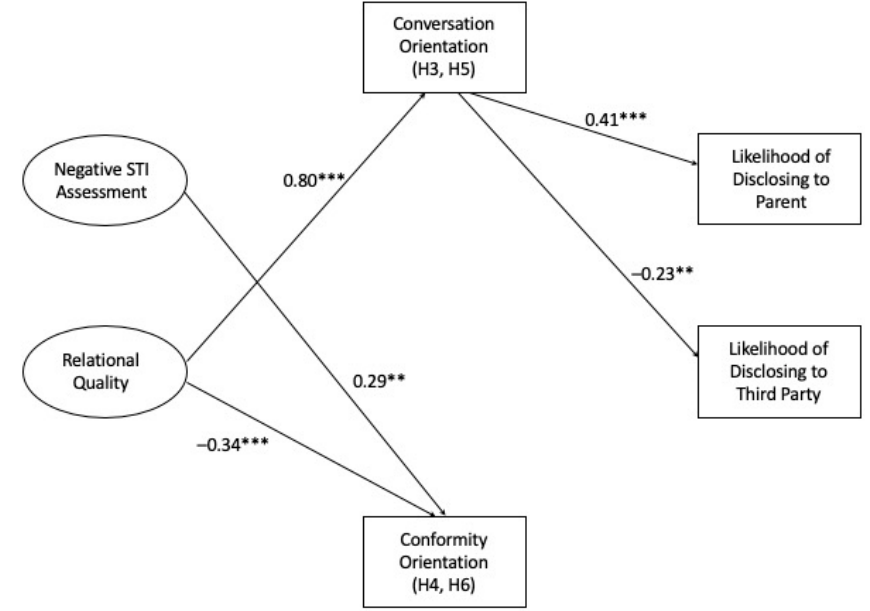
Figure 2. Final model with standardized paths. Note: ** p < 0.01; *** p < 0.001.